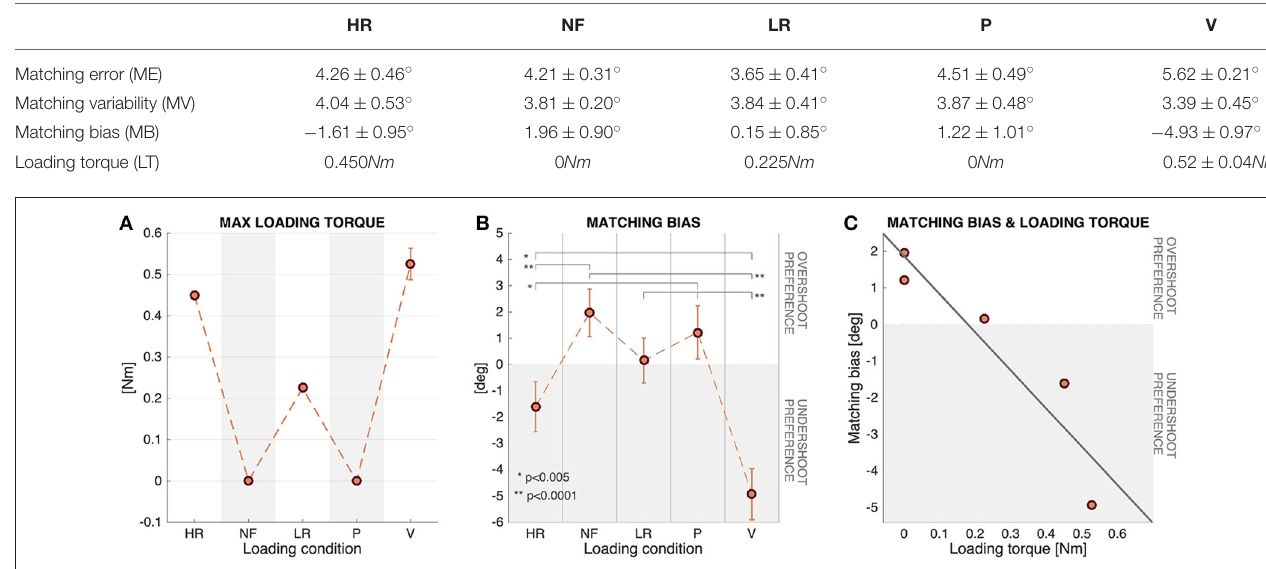
TABLE 2 | Matching error and Error variability (mean and standard error of the 12 subjects) in High Resistive (HR), No-Force (NF), Low Resistive (LR), Passive (P), and Viscous (V) condition.